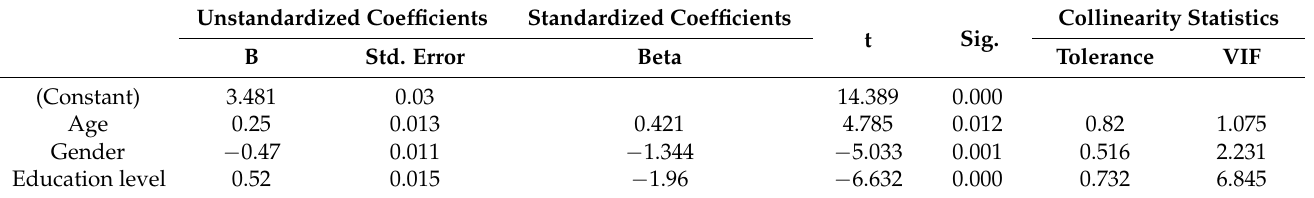
Table 8. Multiple linear stepwise regression